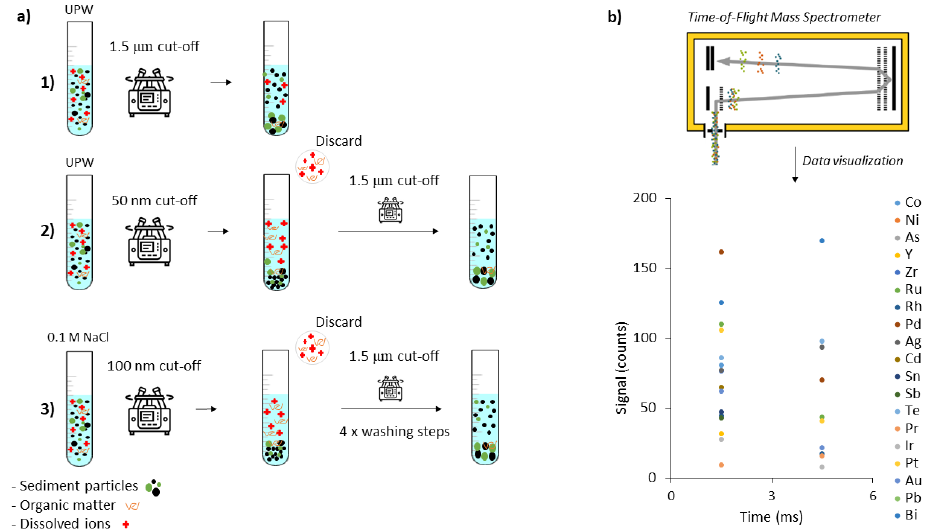
Figure 1. ( a ) Scheme of procedures to extract Pt NPs from the sediment samples: (1) physical one-step, (2) physical two-step, and (3) colloidal extraction procedure. ( b ) Particle detection by spICP-TOF-MS and processed data visualization.